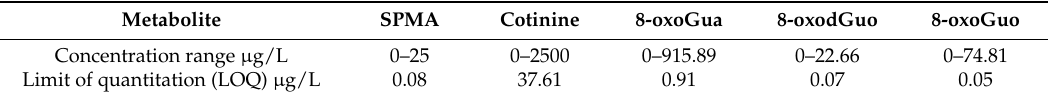
Table 2. Concentration ranges and quantitation limits for the analytes. mercapturic